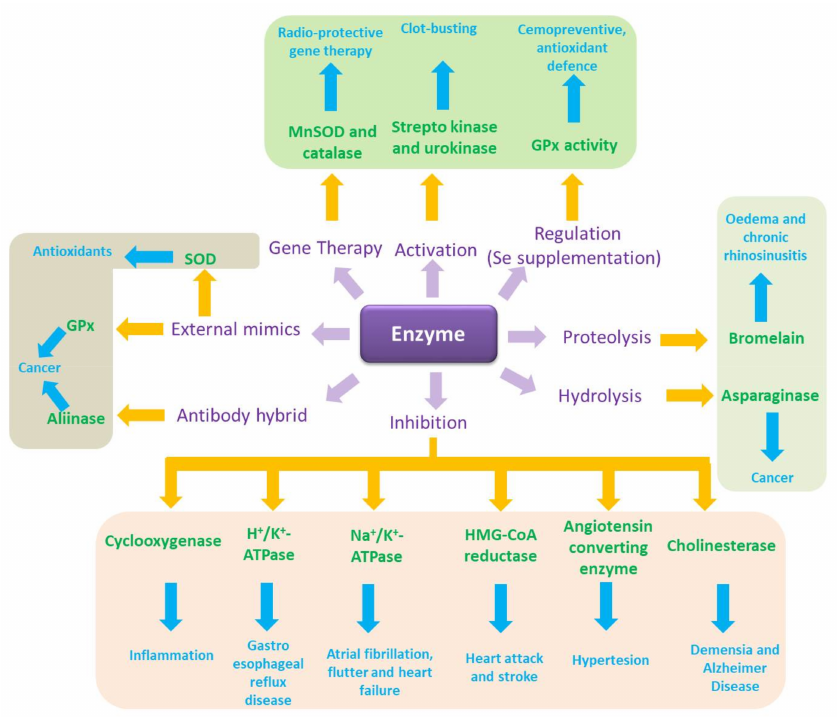
Figure 2. Enzymes take centre stage in innovative drug design, often as targets for inhibitors. See text for